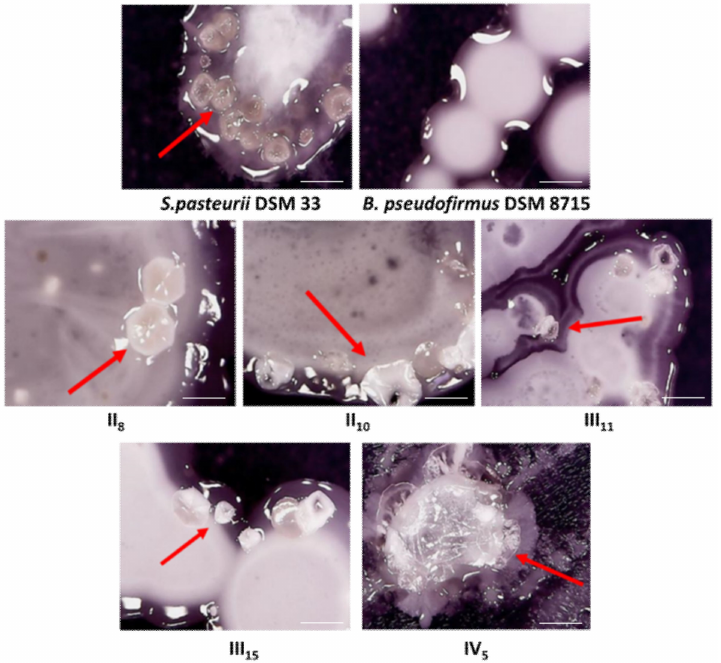
Figure 2. Optical microscopy of bacterial colonies on Urea-CaCl 2 agar (400 × magnifications; scale bar 2 mm; red arrow indicated crystal formation with different positions relative to the colony